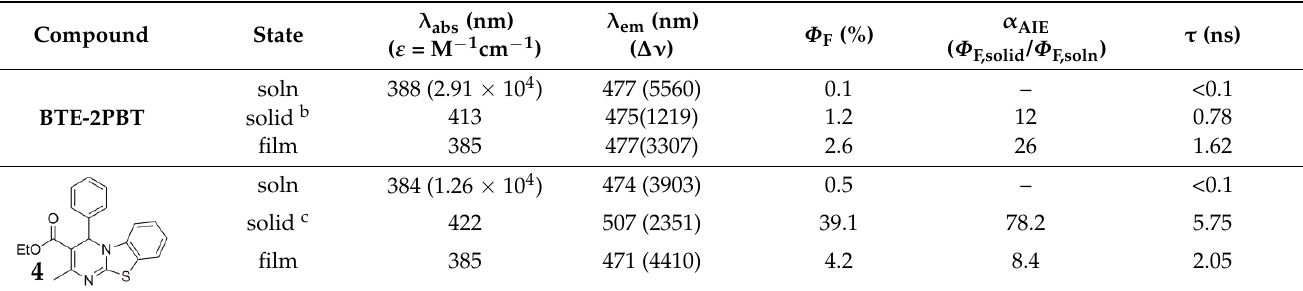
tum yield determined using a calibrated integrating sphere; α AIE = value of AIE effect; τ = fluorescence lifetime measured at room temperature in air; b Determined on amorphous sample; c Determined on crystalline sample.